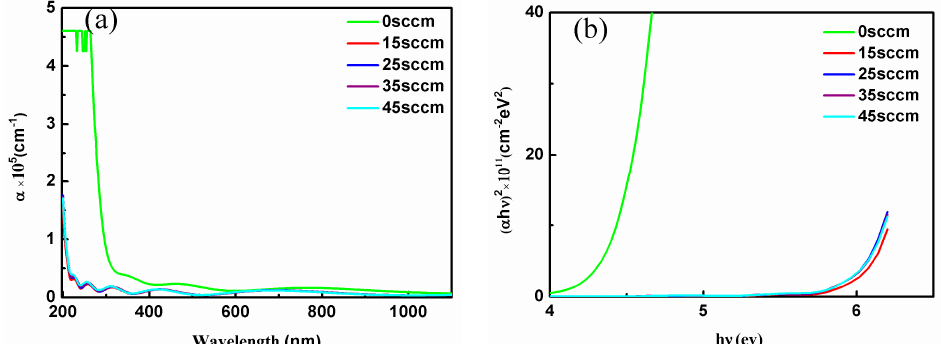
Figure 5. ( a ) Absorption coefficients of Sc 2 O 3 films deposited under different oxygen flow rates; ( b ) ff erent oxygen flow Band gaps of Sc 2 O 3 films deposited under different oxygen flow rates. ( b ) Band gaps of Sc 2 O 3 films deposited under di